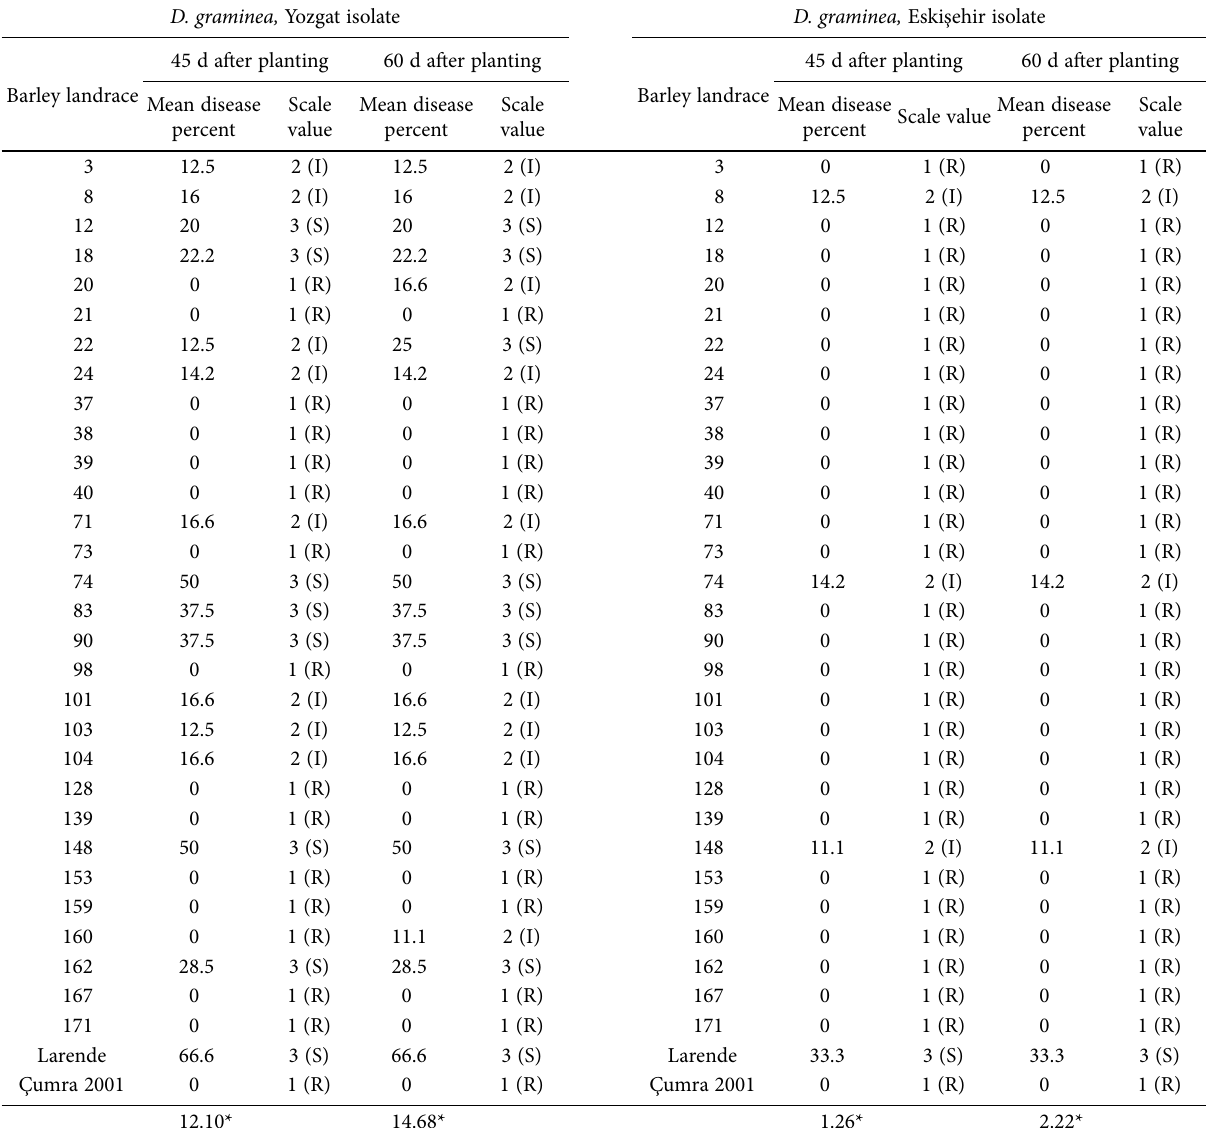
Table 6. Reactions of 30 barley landraces following inoculation with two isolates of Drechslera graminea. For disease valuaes, the scale of Tekauz (1983) was